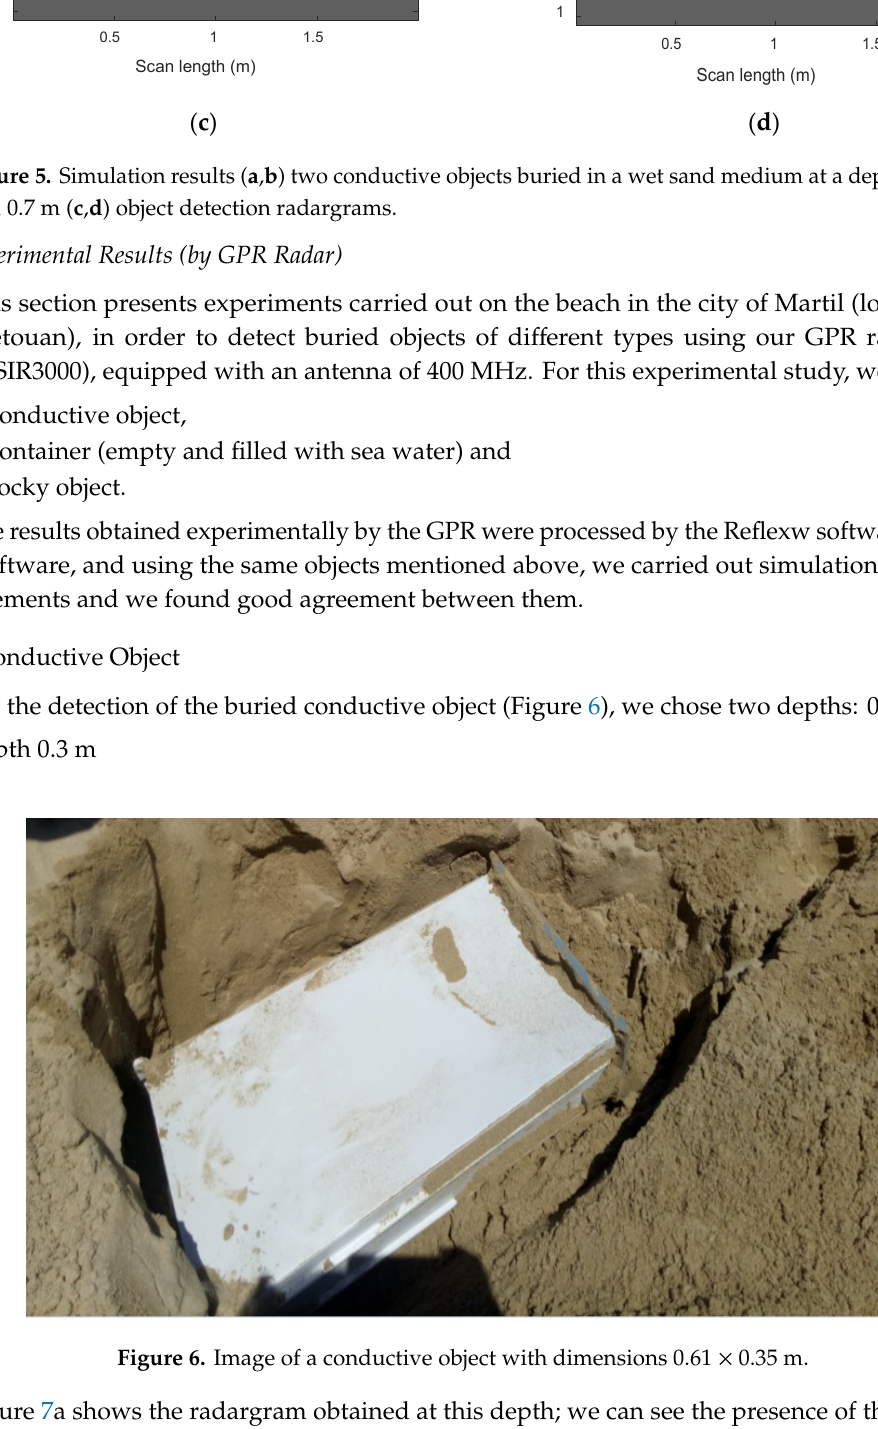
Figure 6. Image of a conductive object with dimensions 0.61 × 0.35 m.